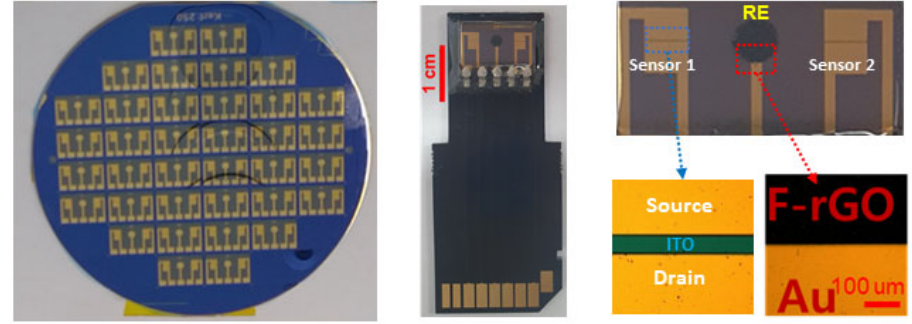
Figure 2. Integrated two-channel ITO-ISFET with F-rGO RE on the sensor tip.